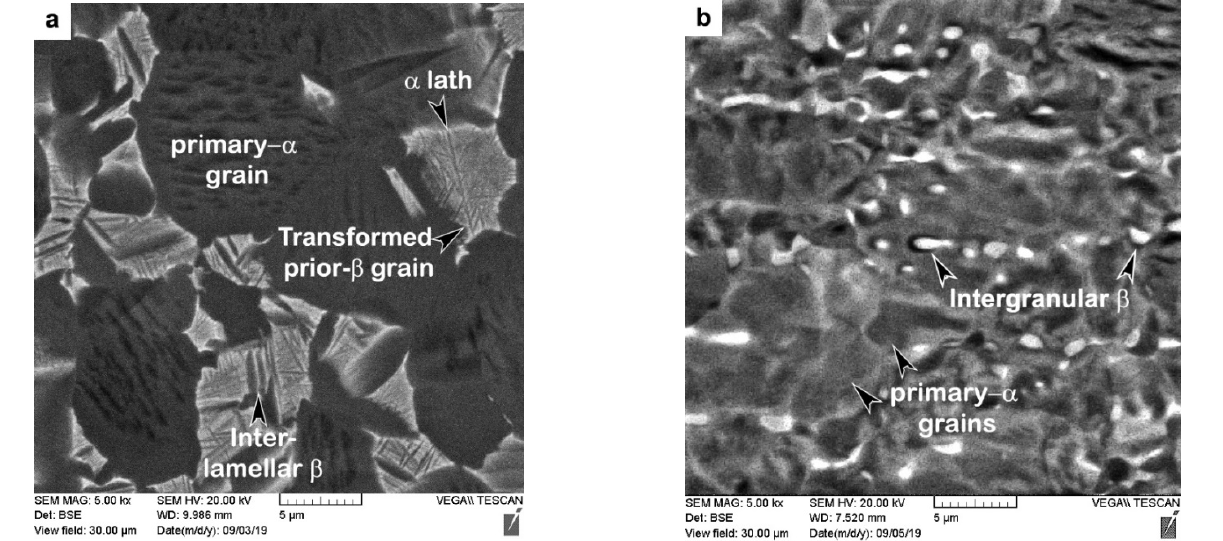
the α grain boundaries. Both the Ti6242 and Ti64 alloys also had a rolled texture that is characteristic of mill-plate titanium alloy products processed thermomechanically.